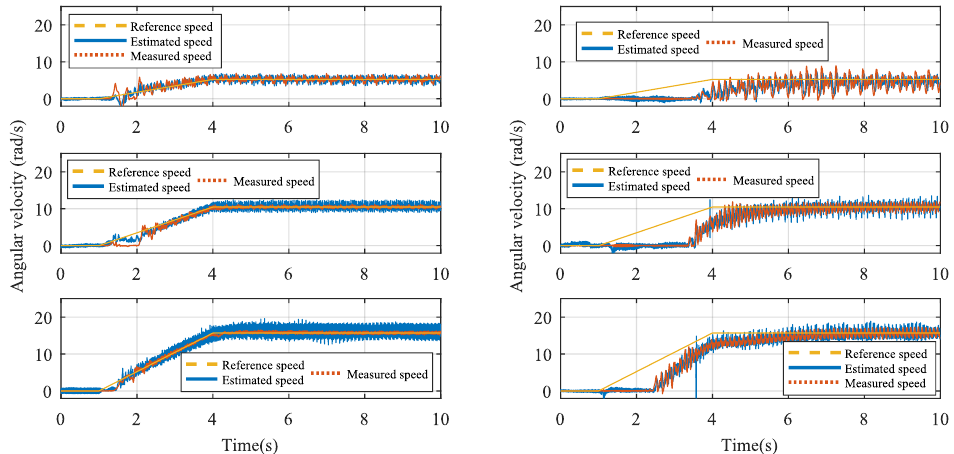
Figure 17. Start up of the motor for three different speeds, from top to bottom 150, 100 and 50 rpm. On the left column the motor is not loaded and in the right column, the load is applied. Reference (dashed yellow), measured (dotted orange) and estimated (solid blue)